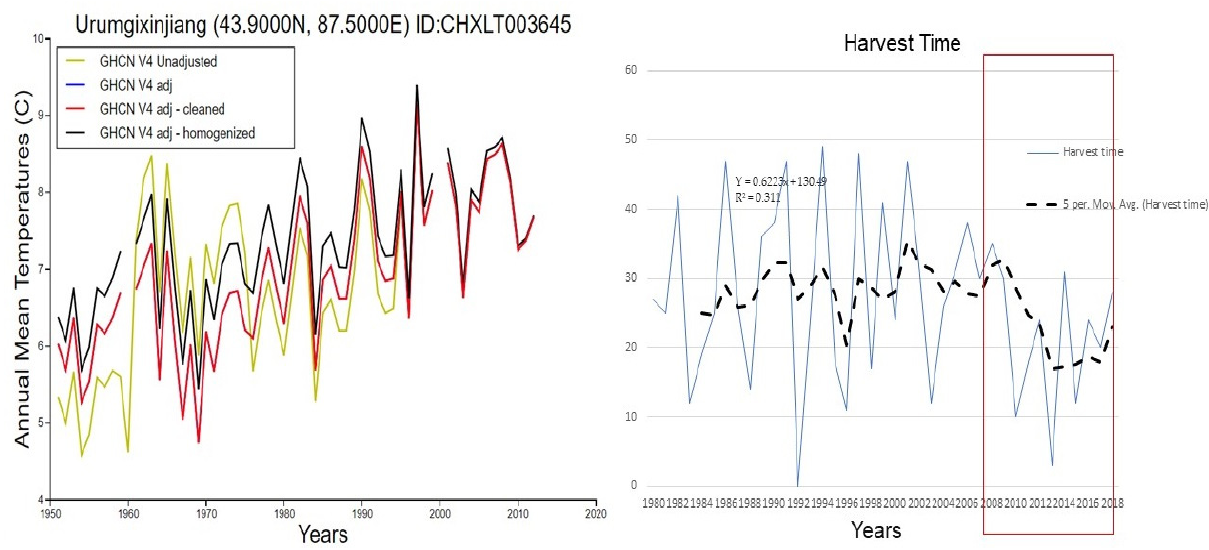
8 of 22 Figure 3. Simulated rends of ( a ) three simulated phenological growth stages of cotton from 1961–2015 in Punjab. Intercept